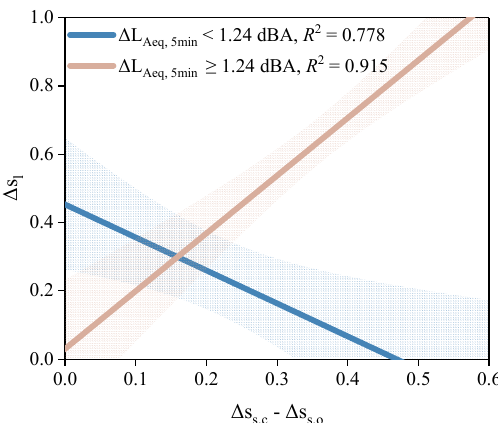
∆ s l and the gap between